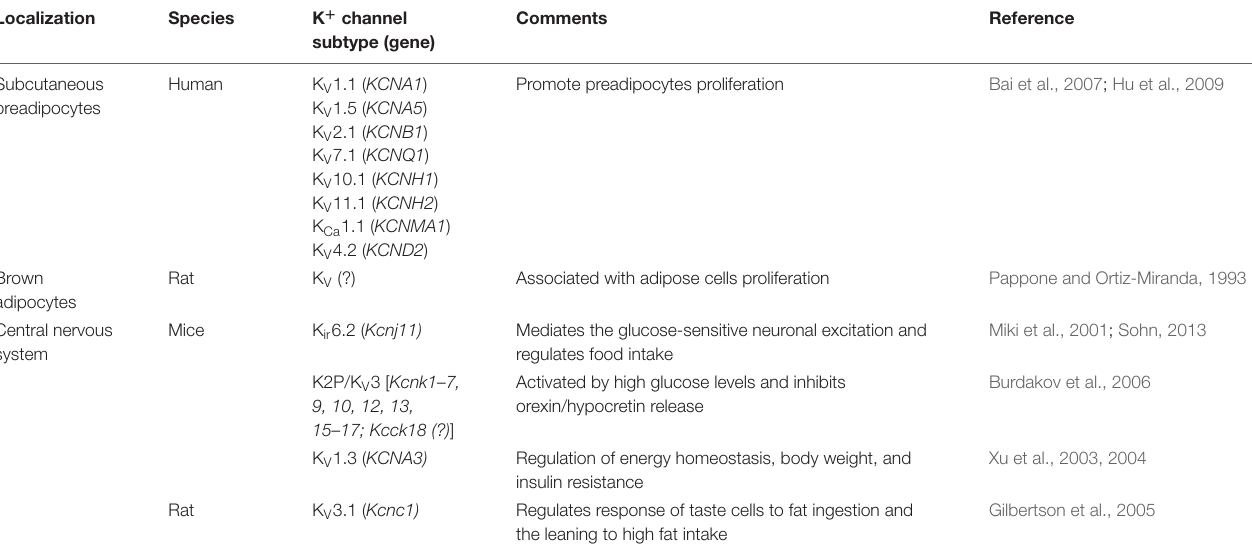
TABLE 1 | Characterization of K + channels associated to